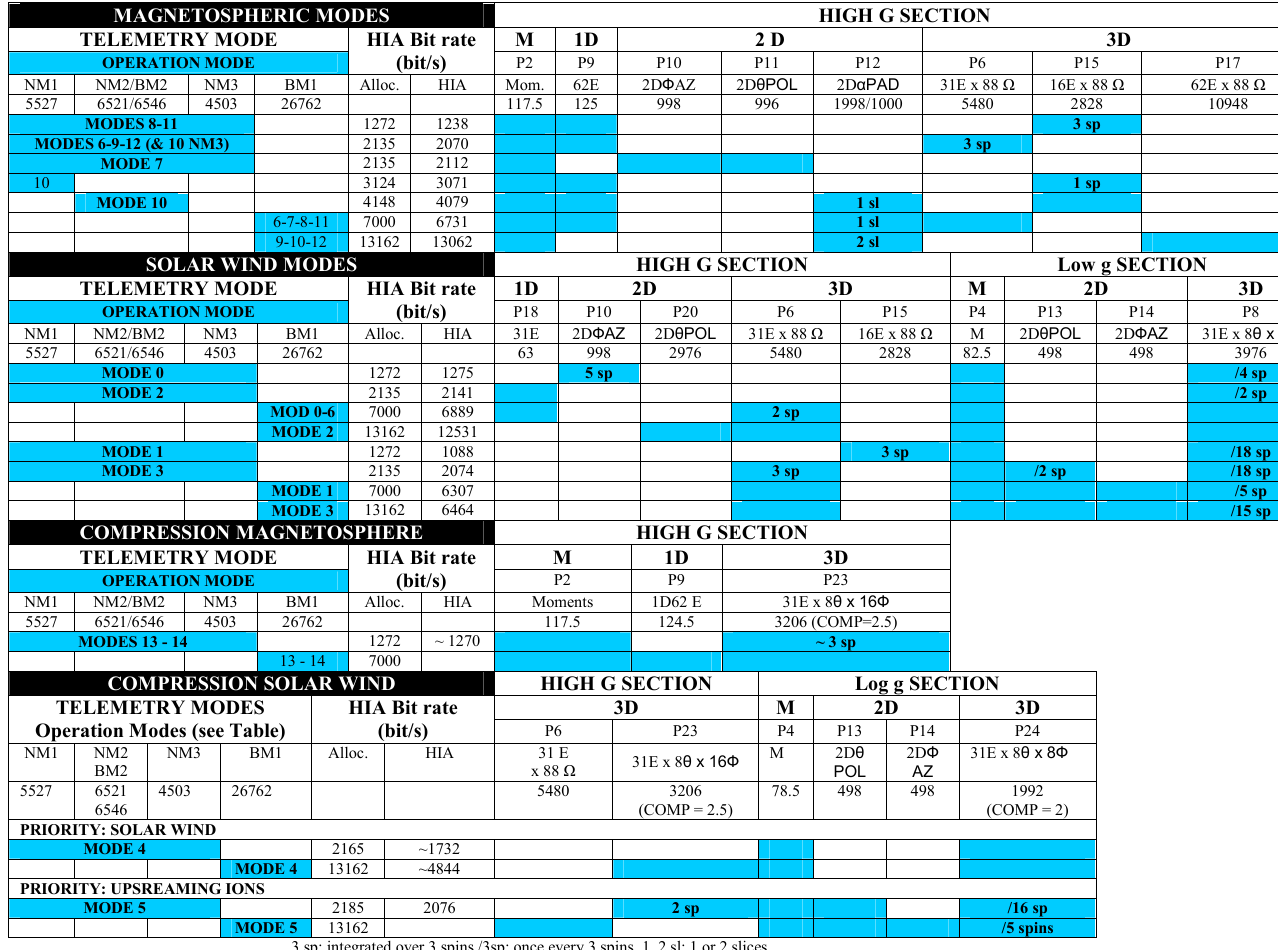
Table 8. CIS 2 Scientific Modes MAGNETOSPHERIC